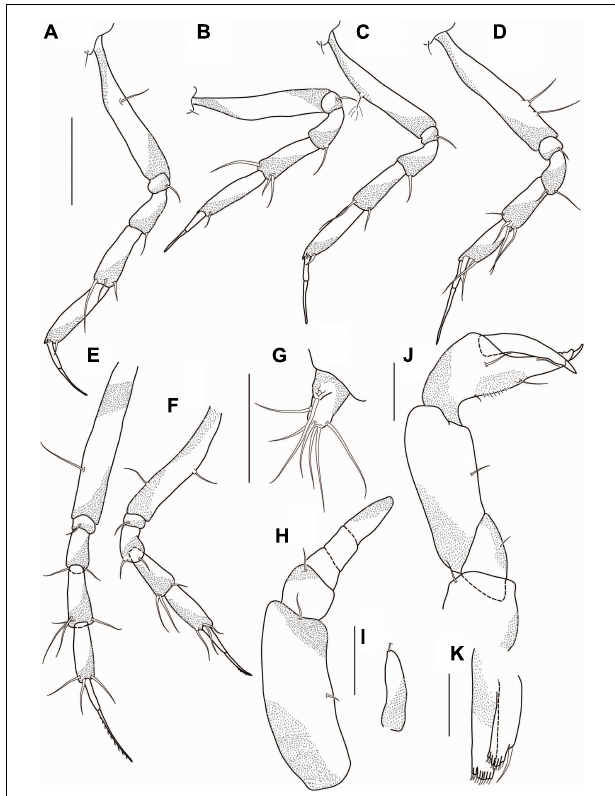
FIGURE 16 | Agathotanais paleroi n. sp., neuter, paratype ( A–G : NHM 58022), juvenile male, paratype ( H–K : ZMH K-61176). (A) Pereopod-1; (B) pereopod-2; (C) pereopod-3; (D) pereopod-4; (E) pereopod-5; (F) pereopod-6; (G) uropod; (H) antennule; (I) antenna; (J) cheliped; (K) pleopod. Scale bar: (A–G) = 100 µ